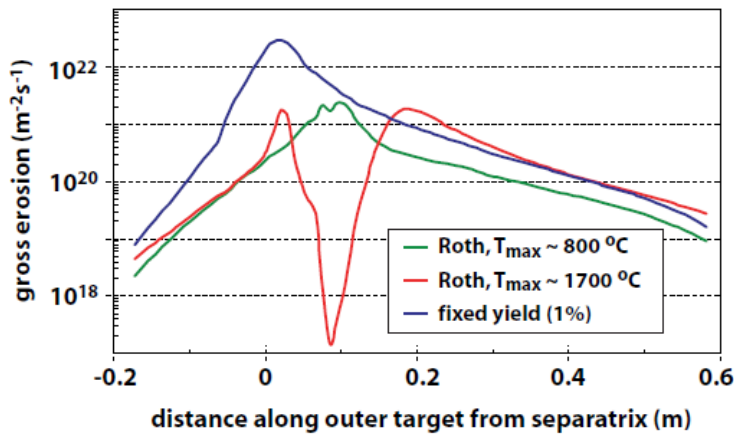
Figure 2. “Calculated chemical gross erosion of the outer ITER divertor target assuming a fixed erosion yield of 1% or the full erosion dependence on energy, surface temperature and particle flux. Calculations are done for a high and a low surface temperature case”. This figure is taken from [18].